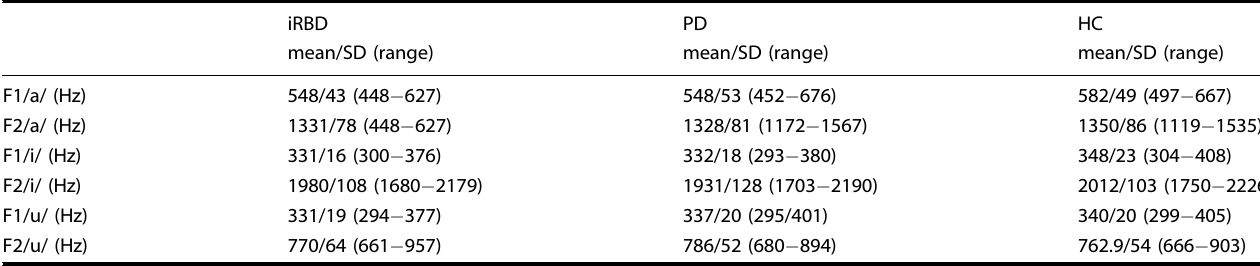
Table 1. Normative values of formant frequencies in male groups of iRBD, PD and HC.